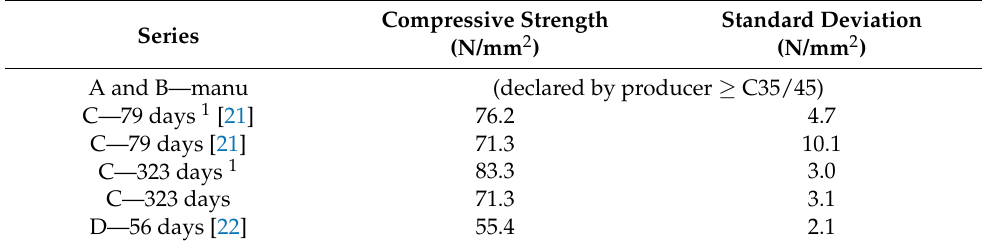
Table 1. Mean compressive cube strength of floor plates. Compressive Strength Standard Deviation Series (N/mm 2 ) (N/mm 2